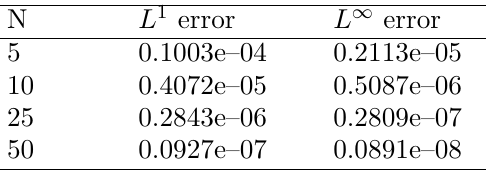
Table 3. L 1 and L ∞ convergence re- sults at x = 1 . 0.